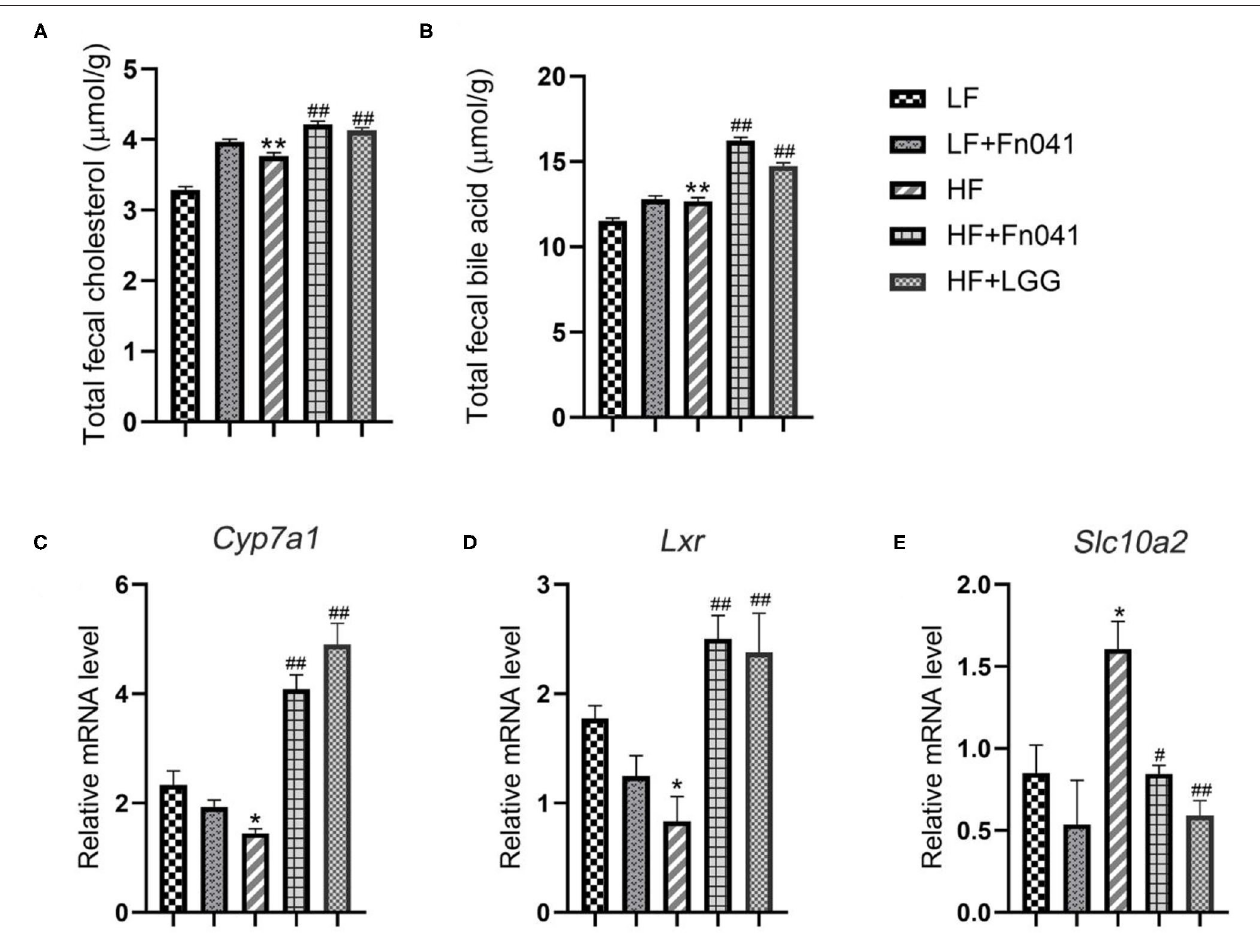
FIGURE 7 | Cholesterol and bile acids in the feces of mice. (A) Total cholesterol content in feces; (B) total bile acid content in feces; (C) liver expression of Cyp7a1 ; (D) liver expression of Lxr ; (E) ileum expression of Slc10a2 ; * p < 0.05, ** p < 0.01 as compared with the LF group; # p < 0.05, ## p < 0.01 as compared with the HF group. ( n = 12/group). LF, low-fat diet group; LF + R, low-fat diet group treated with L. reuteri Fn041; HF, high-fat diet group; HF + R, high-fat diet group treated with L. reuteri Fn041 and Lactobacillus rhamnosus